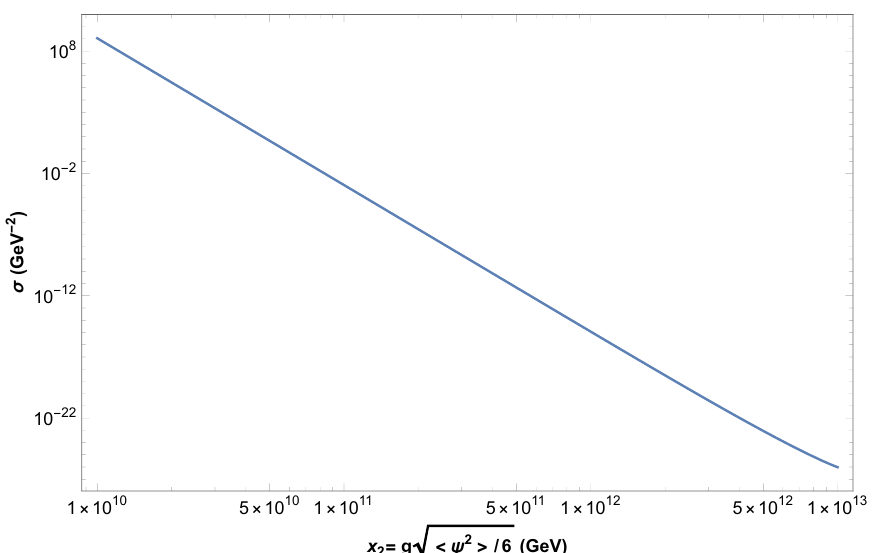
~ C (cid:0) ~ C (cid:0) ! ~ C + plotted against the 1 1 1 1